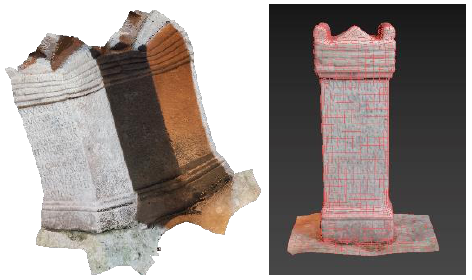
Figure 4. Texturizado y modelo en baja resolución. Ara votiva en 4k.